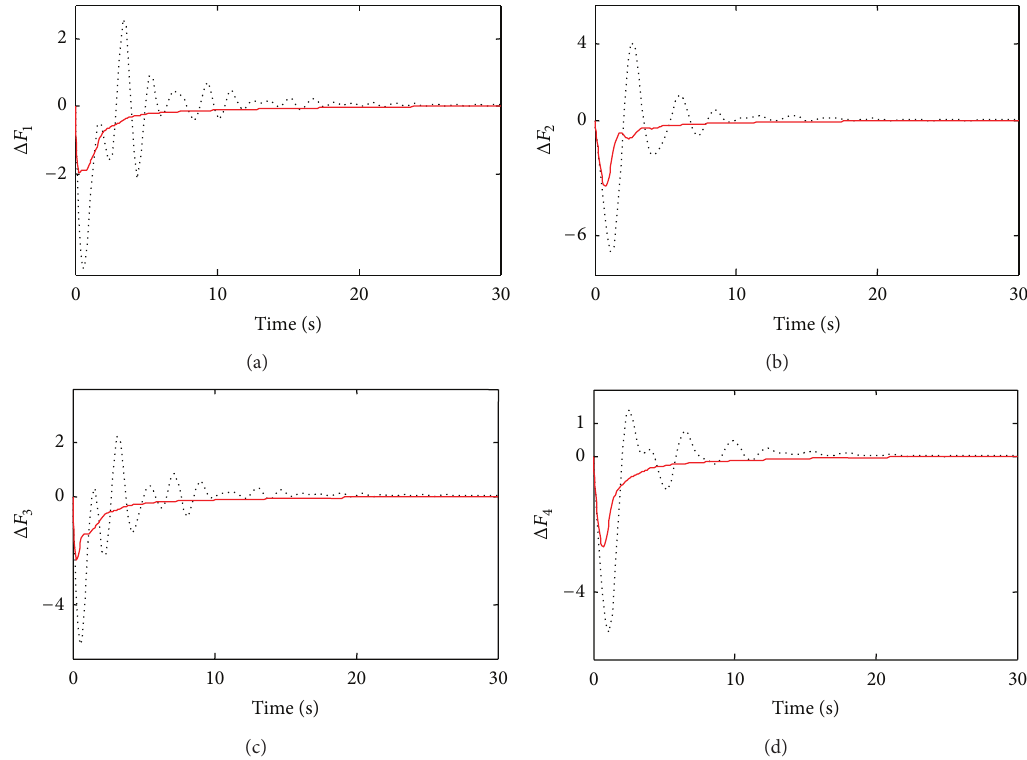
Figure 11: Deviation of frequency; (a) area 1, (b) area 2, (c) area 3, and (d) area 4 for nominal of parameters; Solid (IABC) and Dotted